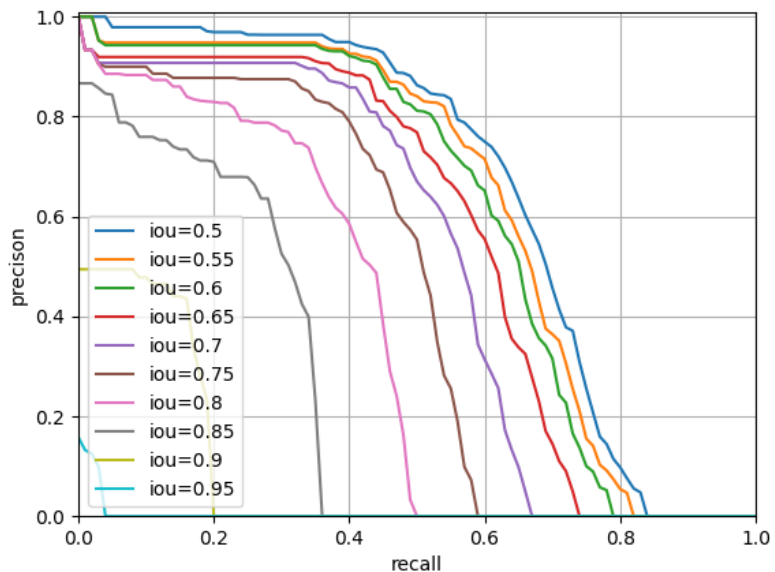
Figure 13. The PR curves of category basketball court on DIOR. The basketball court is one of the categories of DIOR. These curves are achieved by the EFNet as the different IoU s between the predicted boxes and the ground-truths.